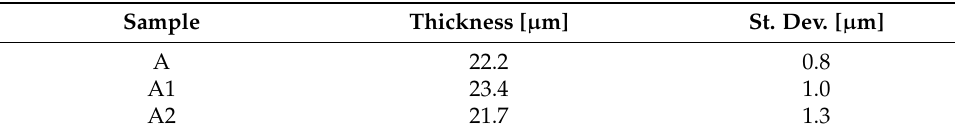
Table 2. Coatings thickness of the three series of samples.